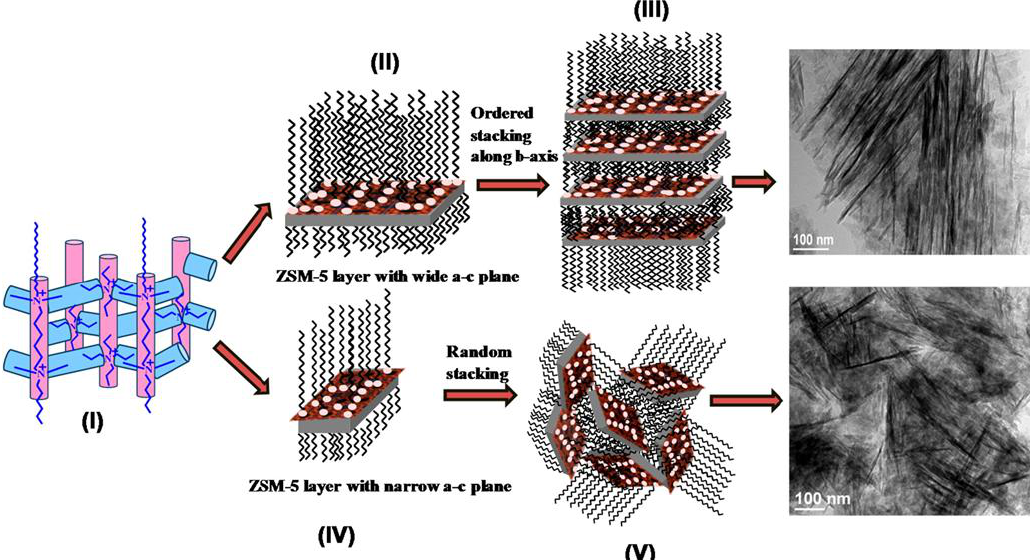
Figure 5. Proposed mechanism for the formation of ZSM-5 nanosheets in the presence of C 18-6-6 and TPABr [47]. Copyright American Chemical Society, 2016.